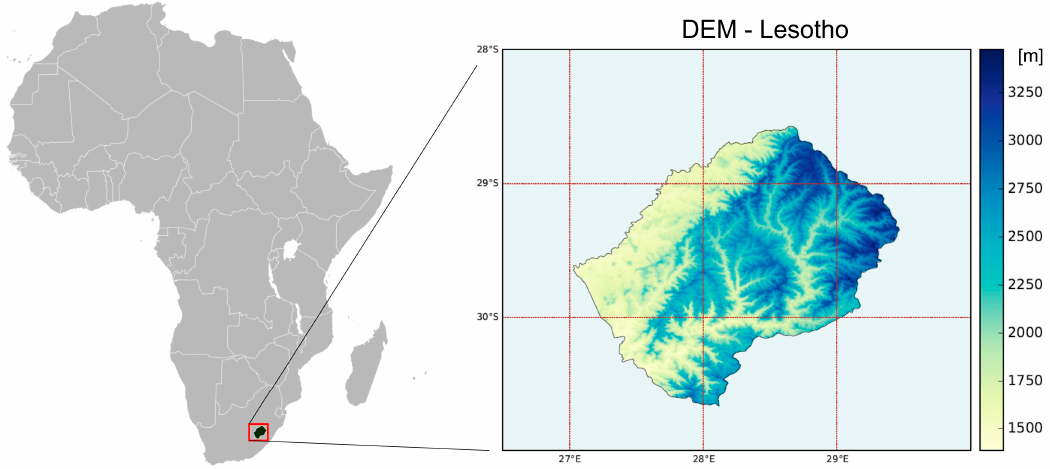
Figure 1. Lesotho in southern Africa ( left ) and digital elevation model of Lesotho (ASTER GDEM) ( right ). Dominating land cover in Lesotho is cropland (below 1800 m) and grassland/shrubland in higher elevations. Only a few square kilometers are covered by natural forests (0.2% of Lesotho) in the low lands [28].